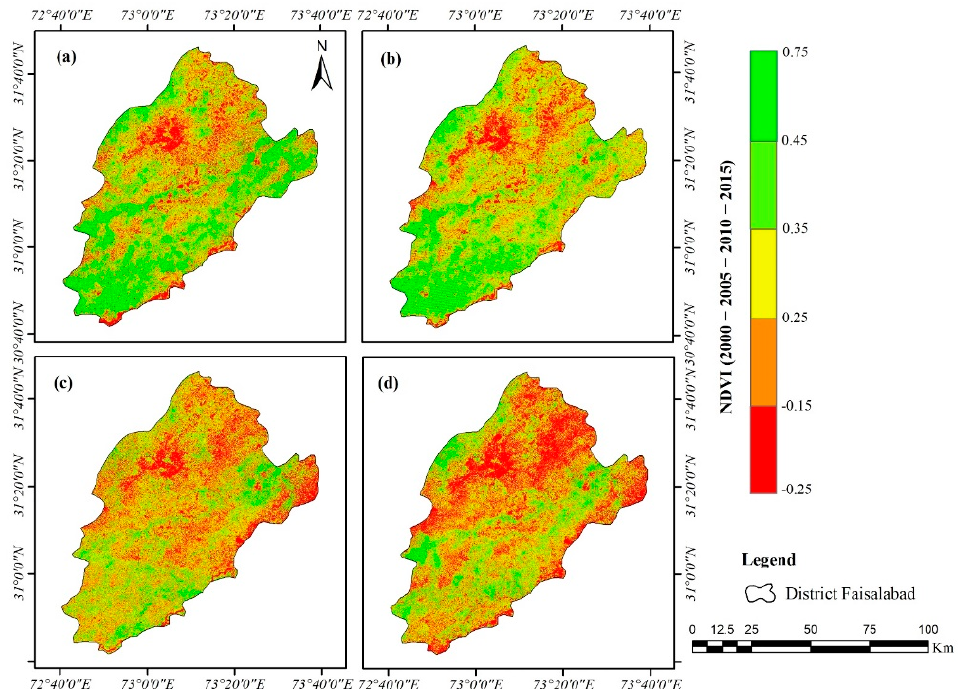
Figure 2. Spatial patterns of normalized difference vegetation index averaged over 3 months (March–May), for 2000 ( a ), 2005 ( b ), 2010 ( c ), and 2015 ( d ).